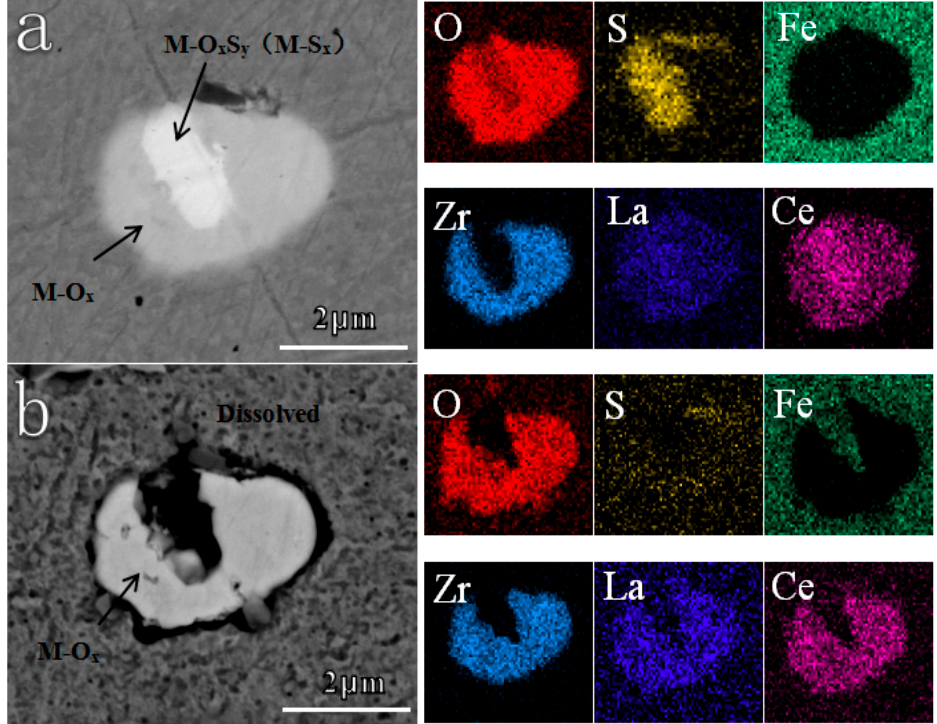
Figure 7. In-situ dissolution behavior of the inclusion in Ti / Zr deoxidized steel after immersion in 0.5 wt.% NaCl for 10 min. ( a ) Before corrosion, ( b ) after corrosion.